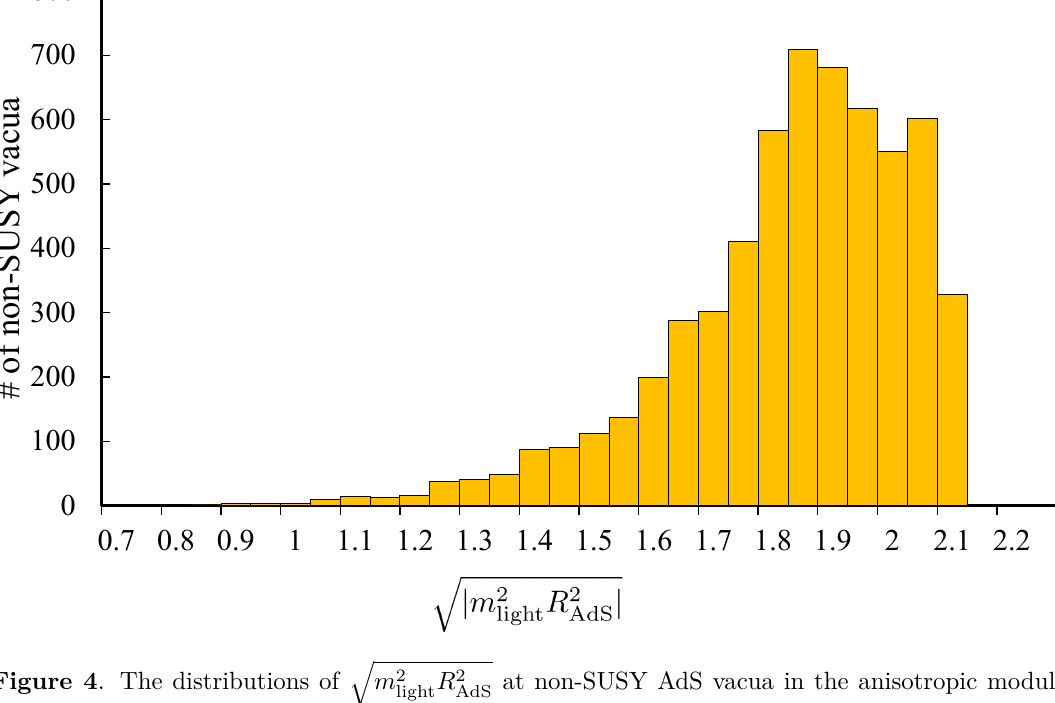
Figure 4 . The distributions of space. All vacua here satisfy the BF